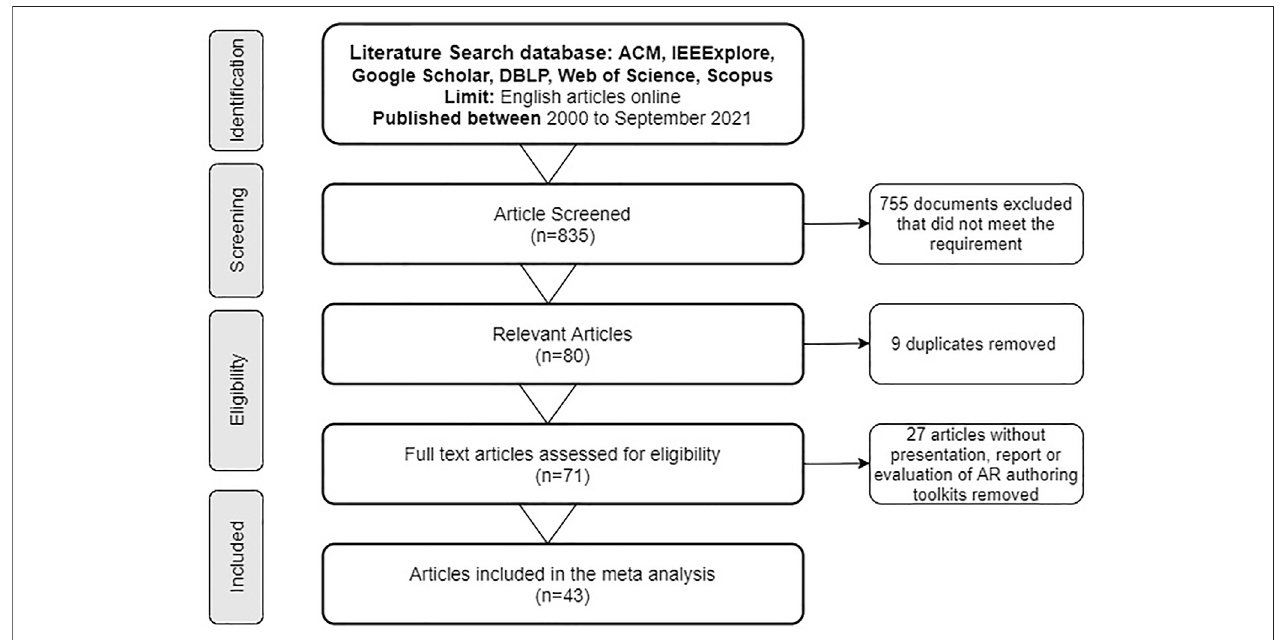
FIGURE 1 | Search process.